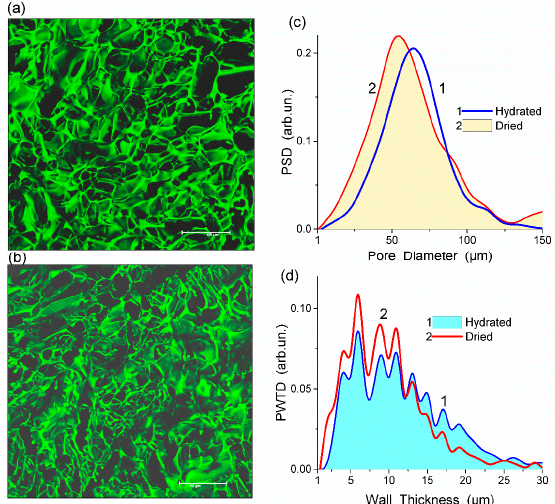
Figure 1. Confocal laser scanning microscopy (CLSM) images of HEMA-AGE hydrogel (sample A) in ( a ) hydrated and ( b ) dried states (scale bar 150 μ m) with the pore ( c ) size and ( d ) wall thickness distributions (reproduced from Ref. [47] with permission from The Royal Society of Chemistry).